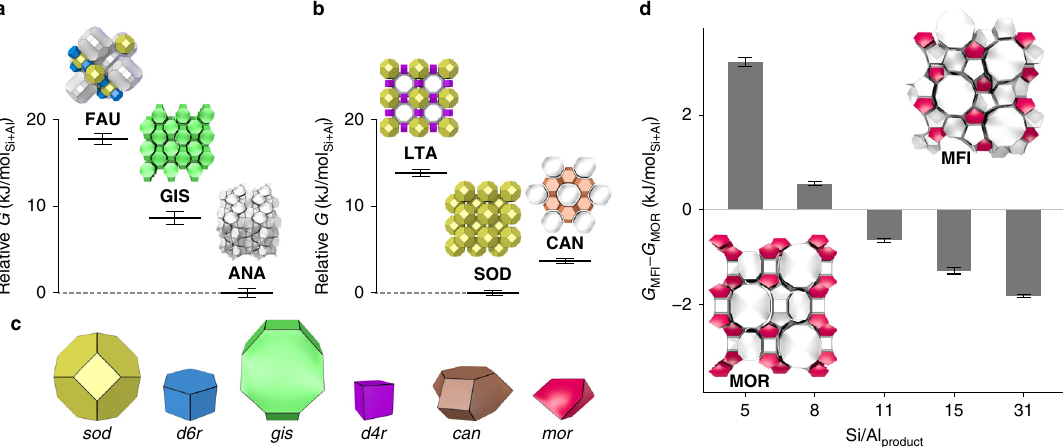
Fig. 4 Relative Gibbs free energies of zeolites and the structural similarity between the crystal structures. a The relative Gibbs free energies of zeolites with Si/Al Product = 2. b The relative Gibbs free energies of zeolites with Si/Al Product = 1 estimated based on the Metropolis Monte Carlo simulations. c Representative building units found in FAU , GIS , ANA , LTA , SOD , CAN , MFI , and MOR structures. d The Gibbs free energy of MFI relative to MOR at different Si/Al Product . Error bars indicate standard deviation in fi ve independent